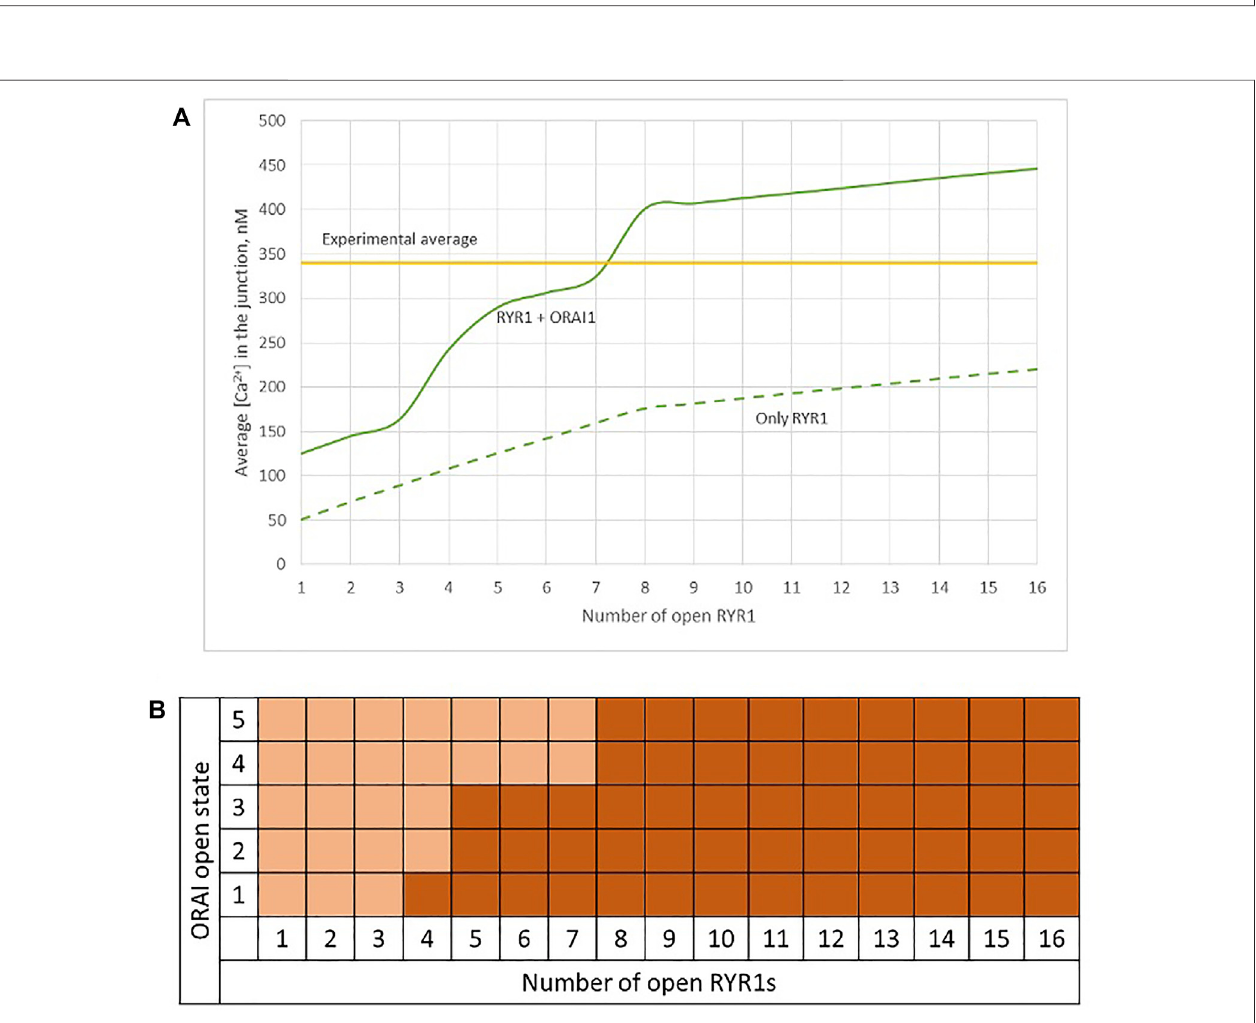
FIGURE 5 | simultaneously open RYR1 in the junction, showing that experimentally observed microdomains can in principle result from the opening of ORAI1 channels induced by the spontaneous opening of a few RYR1 near the junction, in conditions of a full ER. Dotted line represents junctional Ca 2+ concentration reached in the absence of ORAI1 channels. See Anim. S2a,b,c,d and S3 in Supplementary Information